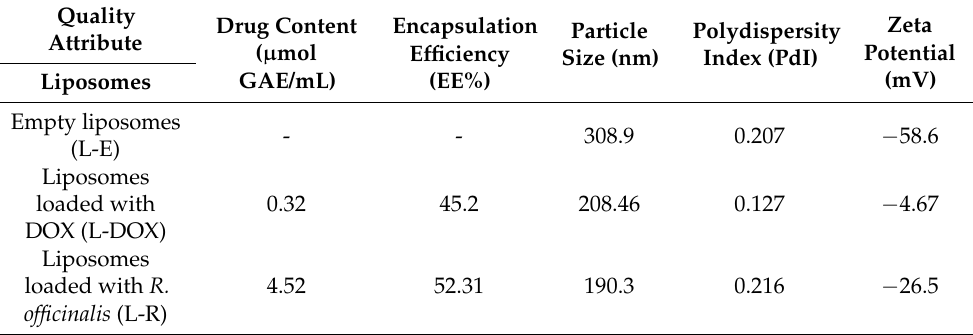
Table 1. Quality attributes of liposomes loaded with R. officinalis leaf extract.